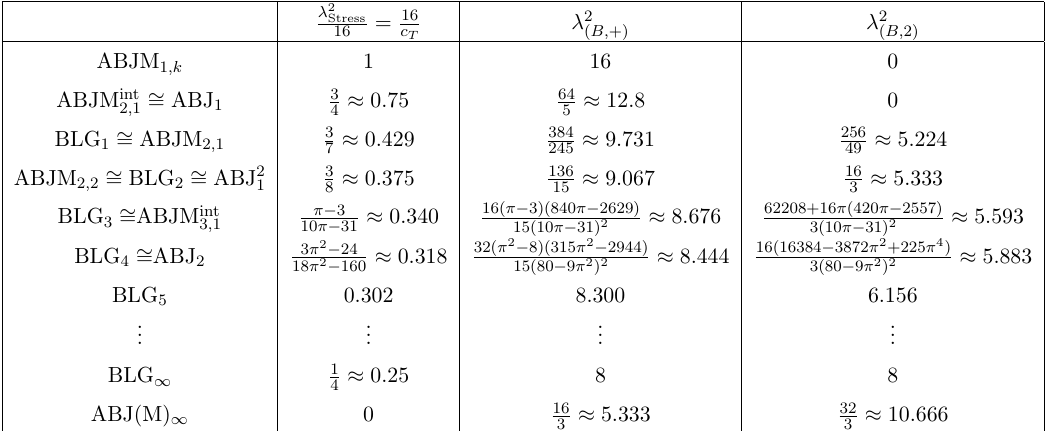
and 1 BPS operators that appear in O Stress (cid:2) O Stress for N = 8 2 4